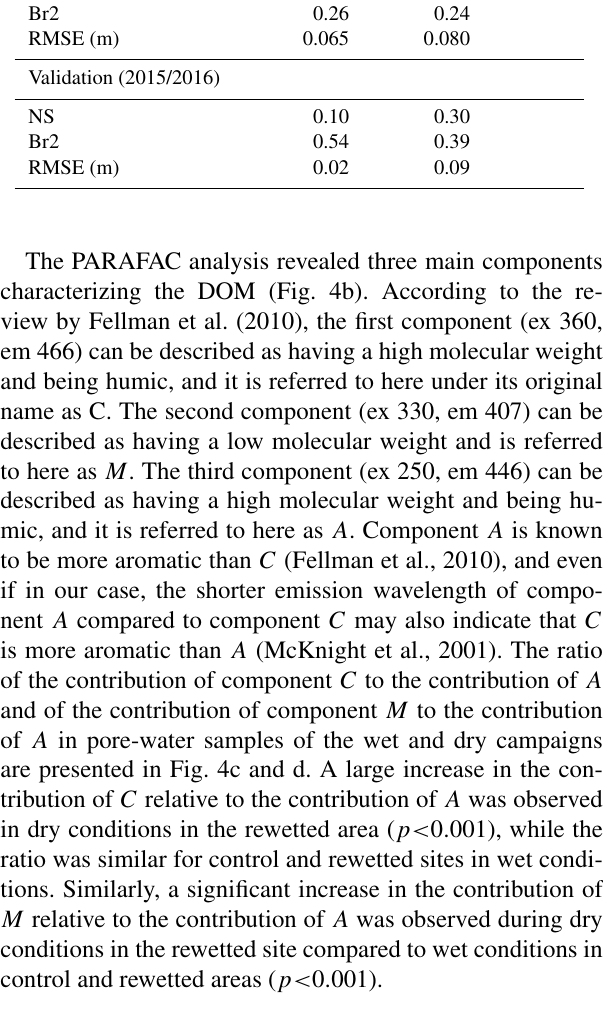
Fig. 5. The simulations presented a RMSE < 9 mg L − 1 for calibration and RMSE < 11 mg L − 1 for validation in both rewetted and control sites, and with no systematic overes- timations or underestimations. The model performed better for the control than for the rewetted site, except for the dri- est year (Table 5). The model was able to reproduce